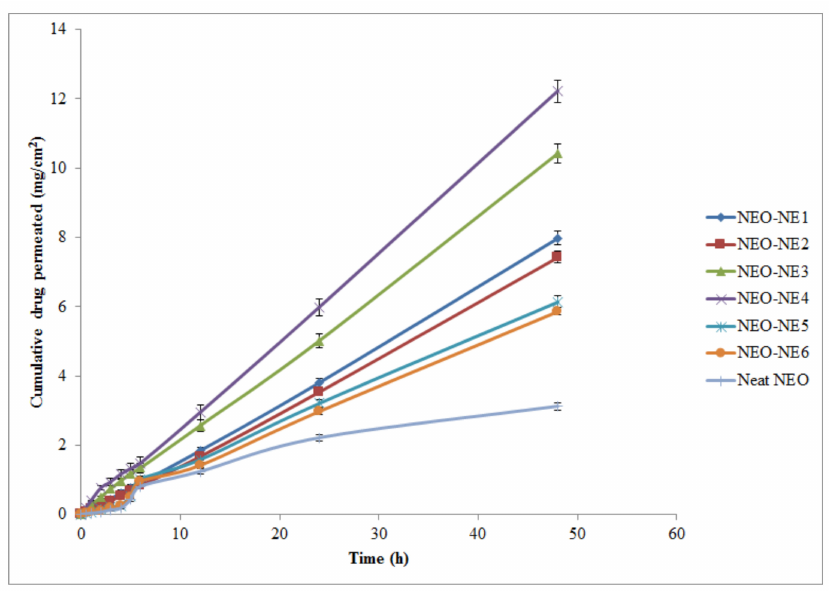
Figure 3. Ex vivo skin permeation profile of different nanoemulsions (NEO-NE 1 –NEO-NE 6 ) and neat NEO (mean ± SD, n = 3.0).